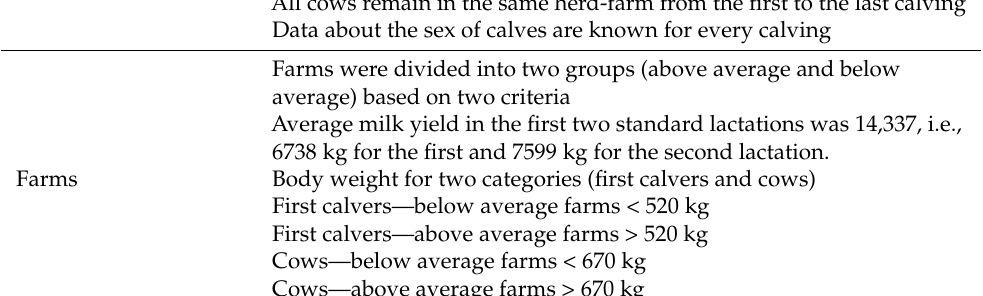
Table 2. Milk yield (X ± SD ) in a standard 305-day lactation (kg) depending on the combination of the sex of offspring after two consecutive calvings and production levels by farms in the first two lactations.